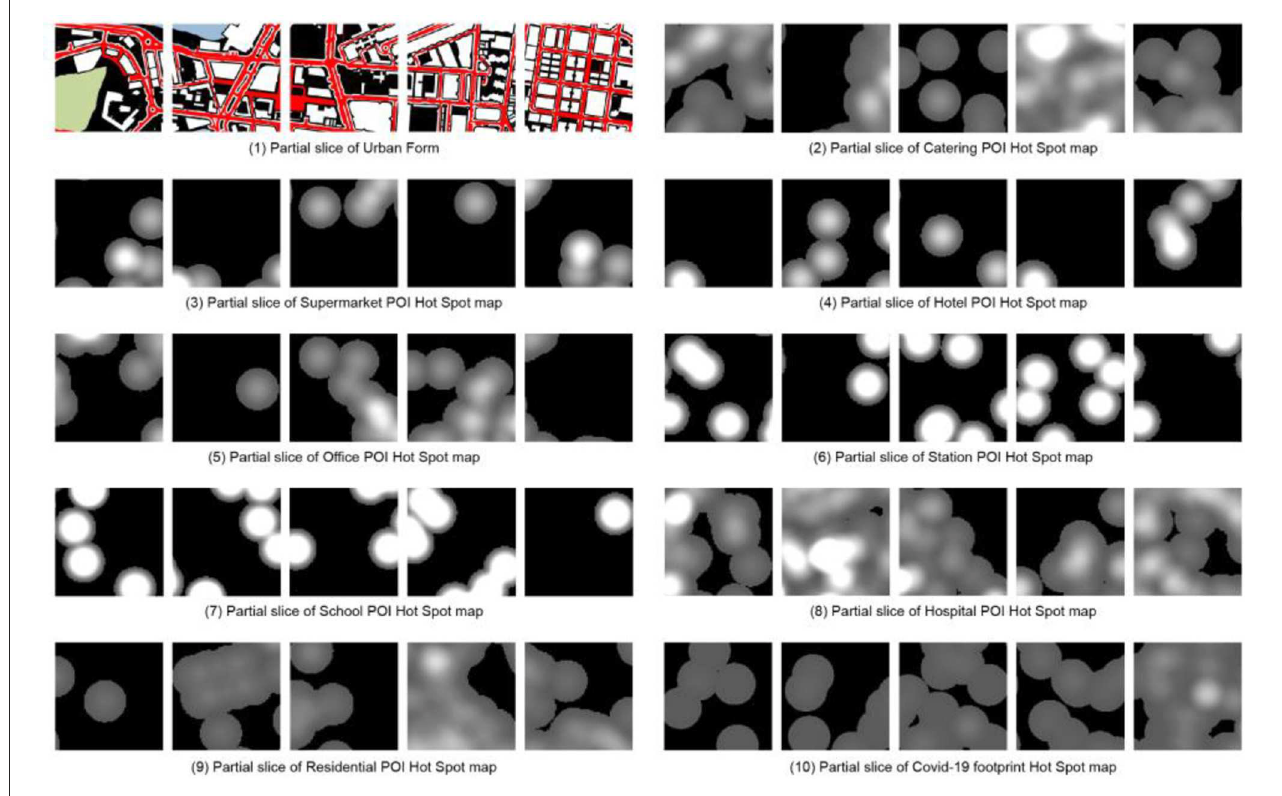
FIGURE3 Sample Sectioning.